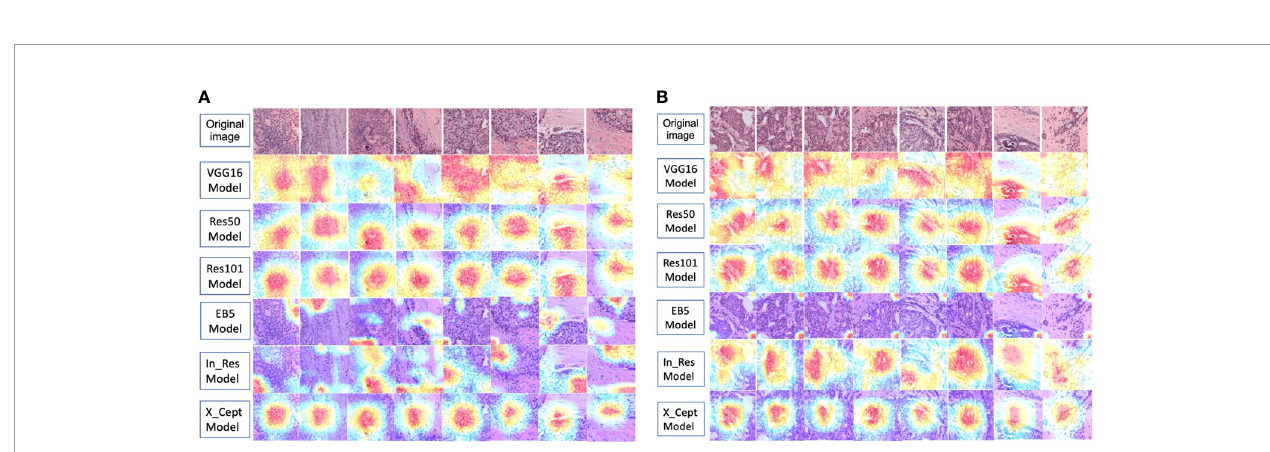
FIGURE 6 | GRAD-CAM visualization of model prediction. (A) Visualization of 6 models ’ prediction for the same set of images from 8 high-risk patients. (B) Visualization of 6 models ’ prediction for the same set of images from 8 low-risk patients. The activation level is shown with a gradient of red, yellow, and blue, which represents high, moderate, and low activation of the risk class, respectively.